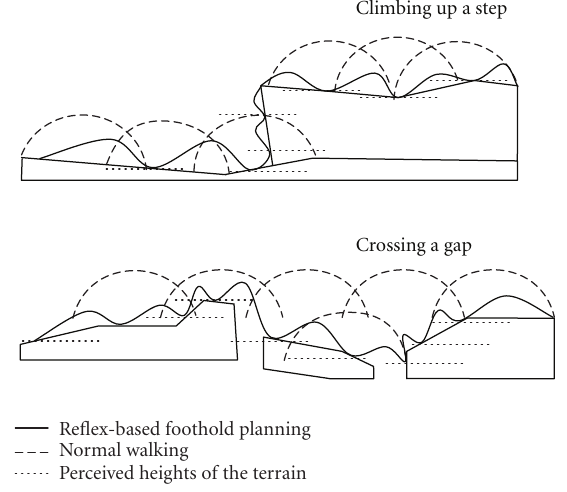
Figure 4: Climbing a step (top) and crossing gaps (bottom) scenarios to present the foothold planning using the proposed Foothold Reflex Control method. Normal walking behavior is mo- mentarily changed upon sensing an obstruction. Once the obstruc- tion is removed (e.g., loss of contact with the obstruction), the normal motions are